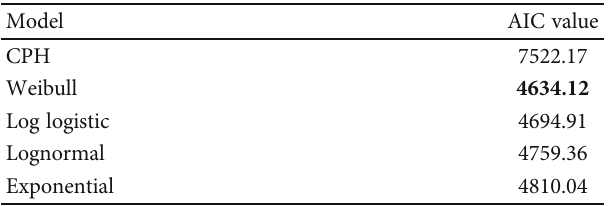
Table 4: Comparison of the pH model and the AFT models using AIC